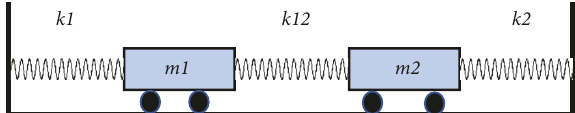
Figure 2: Graphical representation of the mass-spring